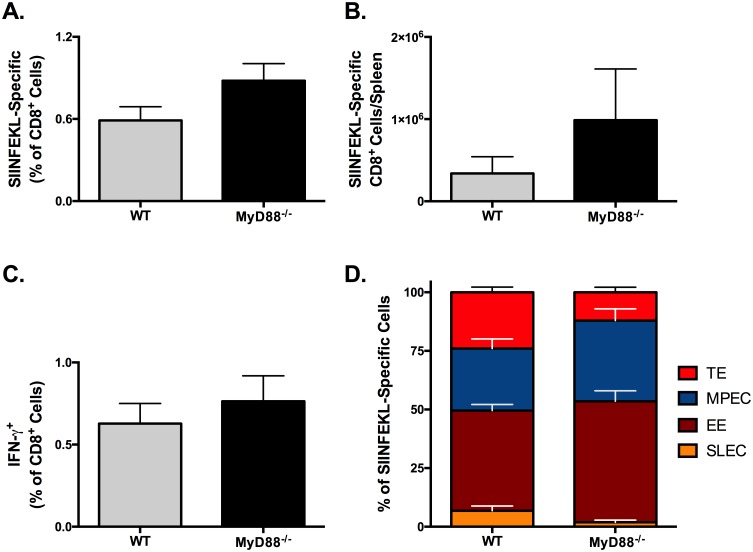
MyD88-deficiency Does Not Affect the Magnitude of Primary CTL Responses to SQ Adjuplex Vaccines, but Does Alter Memory Differentiation.Cohorts of wild type (WT) and MyD88-/- mice were vaccinated SQ with 10 μg OVA and 5% ADJ in 50 μl PBS. On day 8 after vaccination, spleens were collected and the frequency, number and phenotype of SIINFEKL-specific CTLs were characterized by flow cytometry. (A) Frequency of SIINFEKL-tetramer+ CTLs cells in the spleen among all CD8+ lymphocytes. (B) Absolute numbers of SIINFEKL-tetramer+ CTLs in the spleen. (C) Frequency of SIINFEKL-specific IFN-γ+ CTLs cells in the spleen among all CD8+ lymphocytes. (D) Percentages of SLECs (KLRG-1HICD127LO), MPECs (KLRG-1LOCD127HI), transition effectors (TEs; KLRG-1HICD127HI) and early effectors (EEs; KLRG-1LOCD127LO) among SIINFEKL-specific CD8 T cells in spleen. Data are from 3–5 mice/group and representative of two independent experiments. * indicates p<0.05.